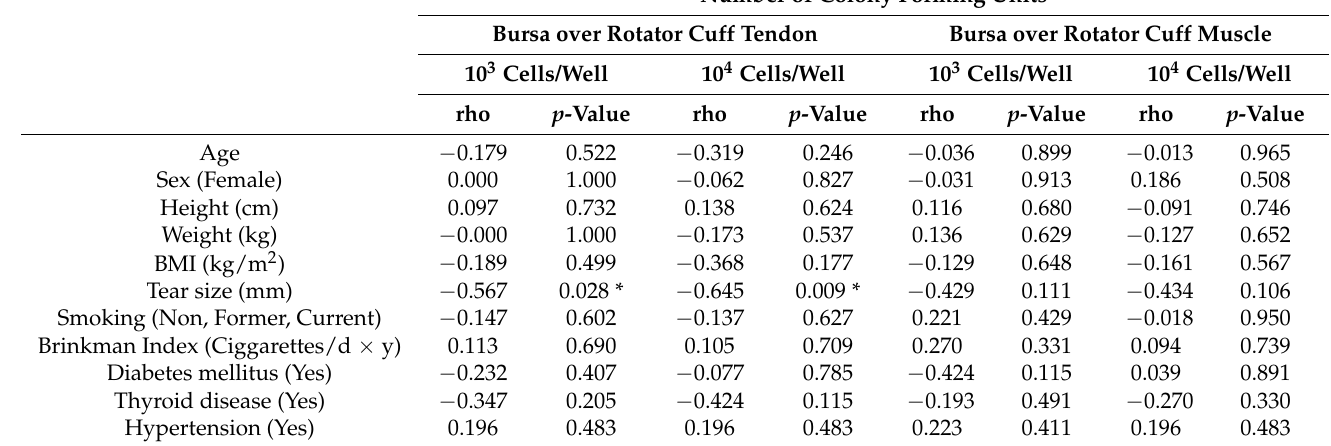
Table 1. Spearman’s rank correlation coefficient analysis of the number of Colony-Forming Units (CFUs) by cells from SB over the RC tendon and muscle. Correlation analysis between the number of CFUs and patient demographics was completed. While tear size was negatively correlated to the number of CFUs from both the cells from the SB over the RC tendon, there was no statistical correlation with other demographics. (* = significance p < 0.05).